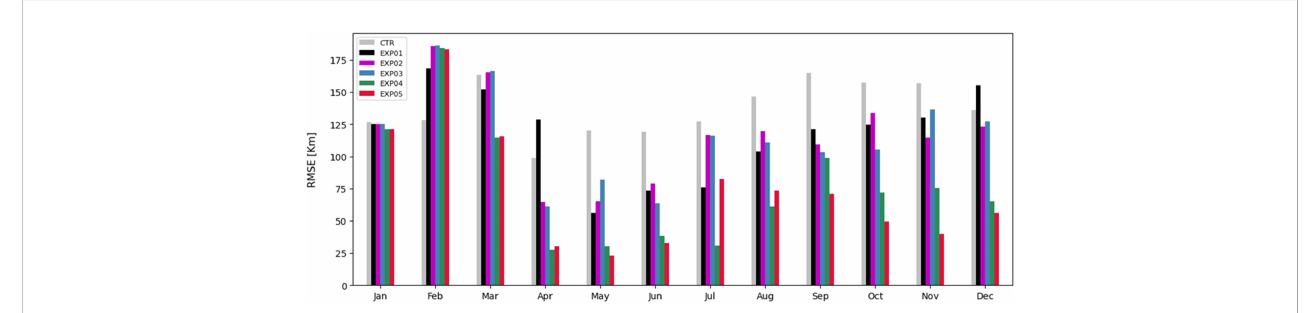
FIGURE 9 Monthly mean RMSEs for the latitude of the Kuroshio axis with respect to the observation data of each experiment. Gray, black, violet, blue, green and red bars denote CTR and EXP01-05,